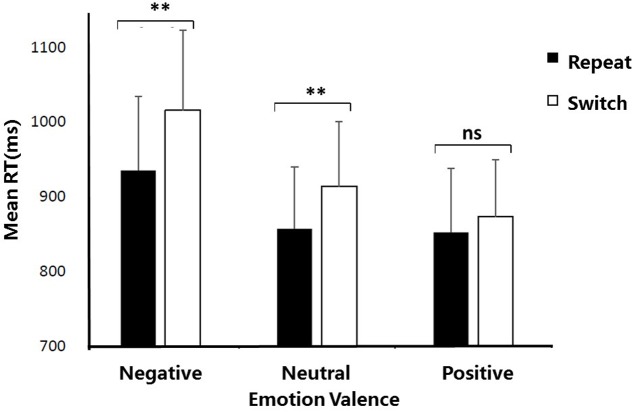
Mean reaction times as a function of Emotion valence and Trial type. ∗p < 0.05; ∗∗p < 0.01; ns, no significance. Error bars indicate the standard deviation.